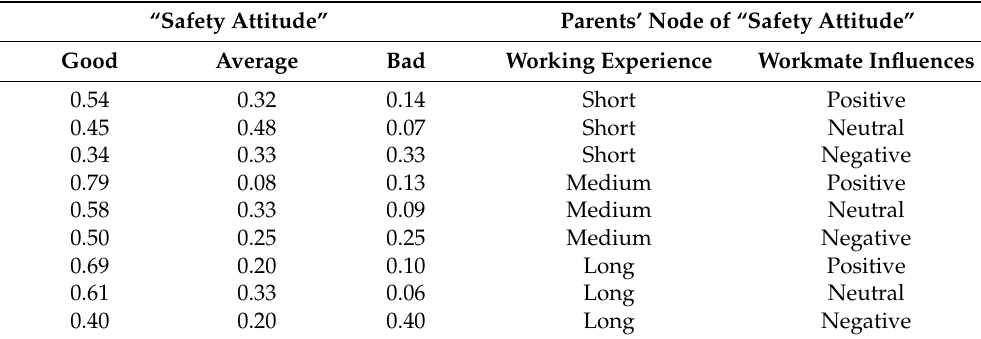
Table 4. Conditional probability table (CPT) of the “safety attitude”